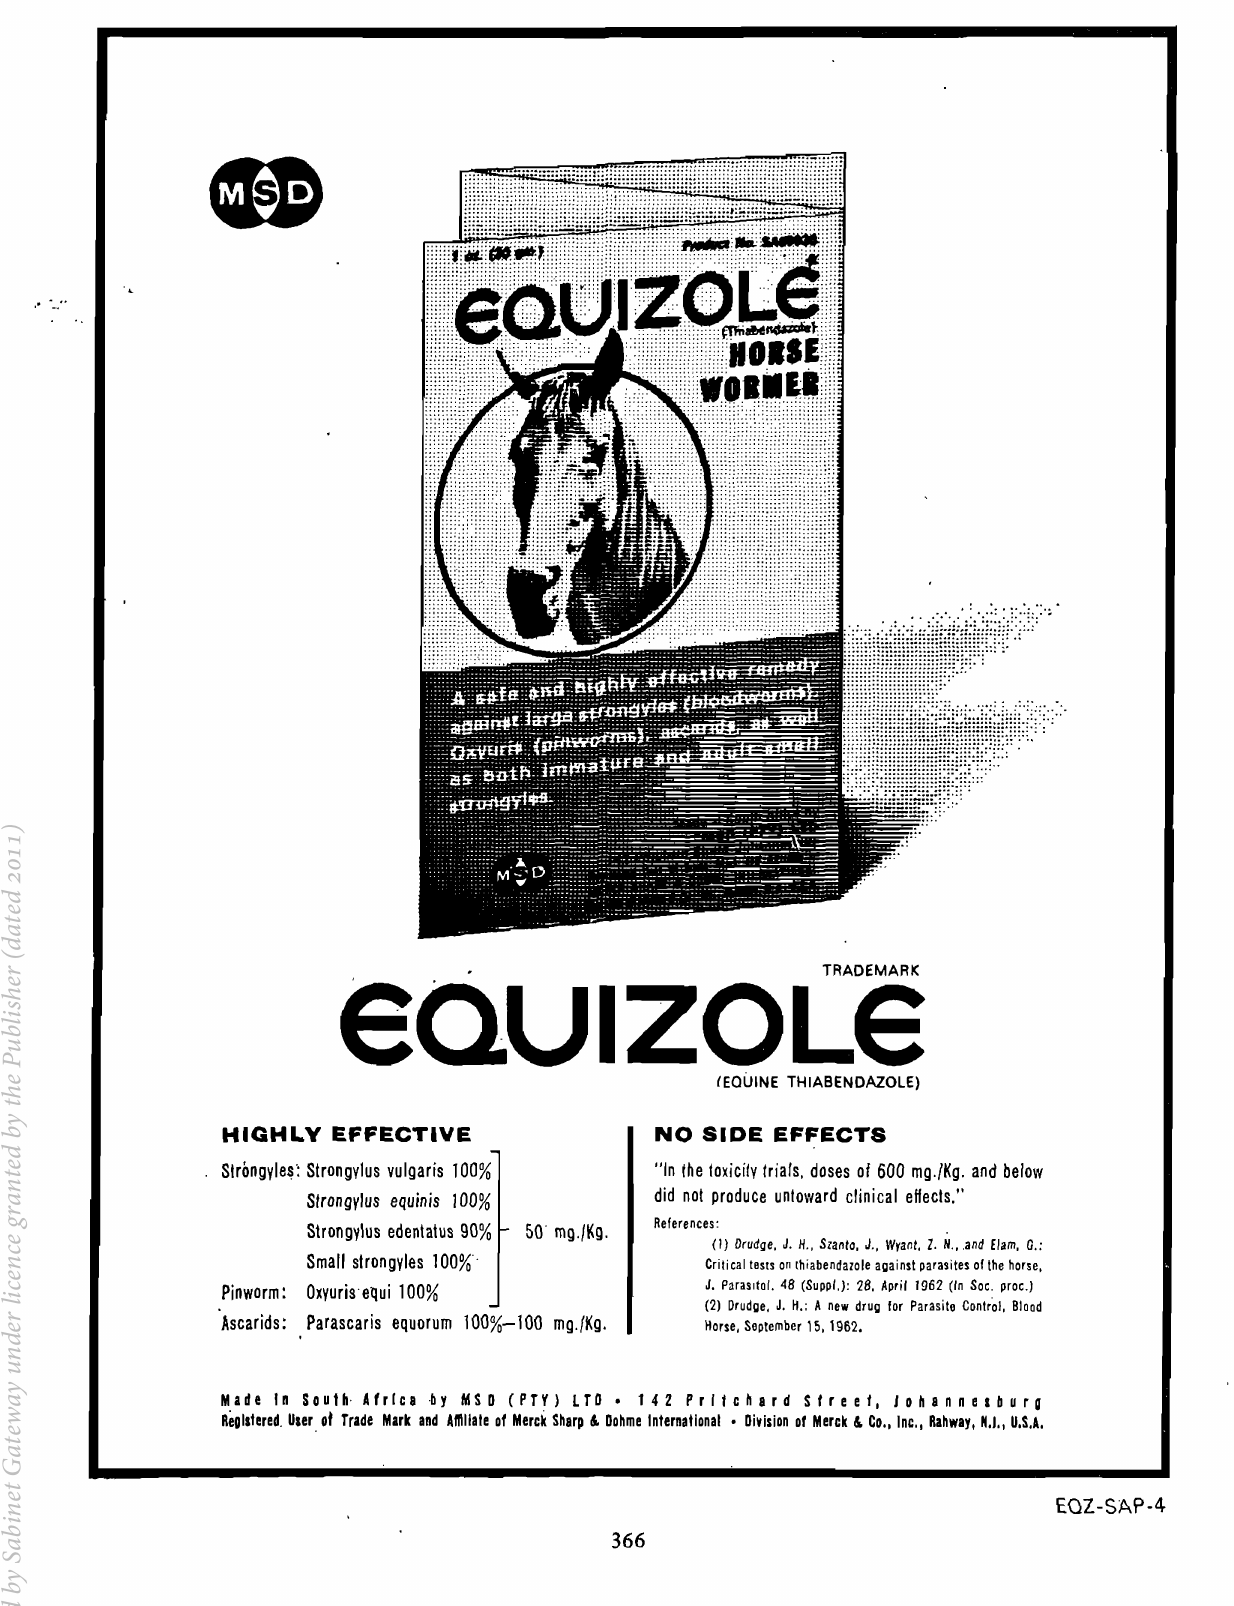
HIGHLY EFFECTIVE